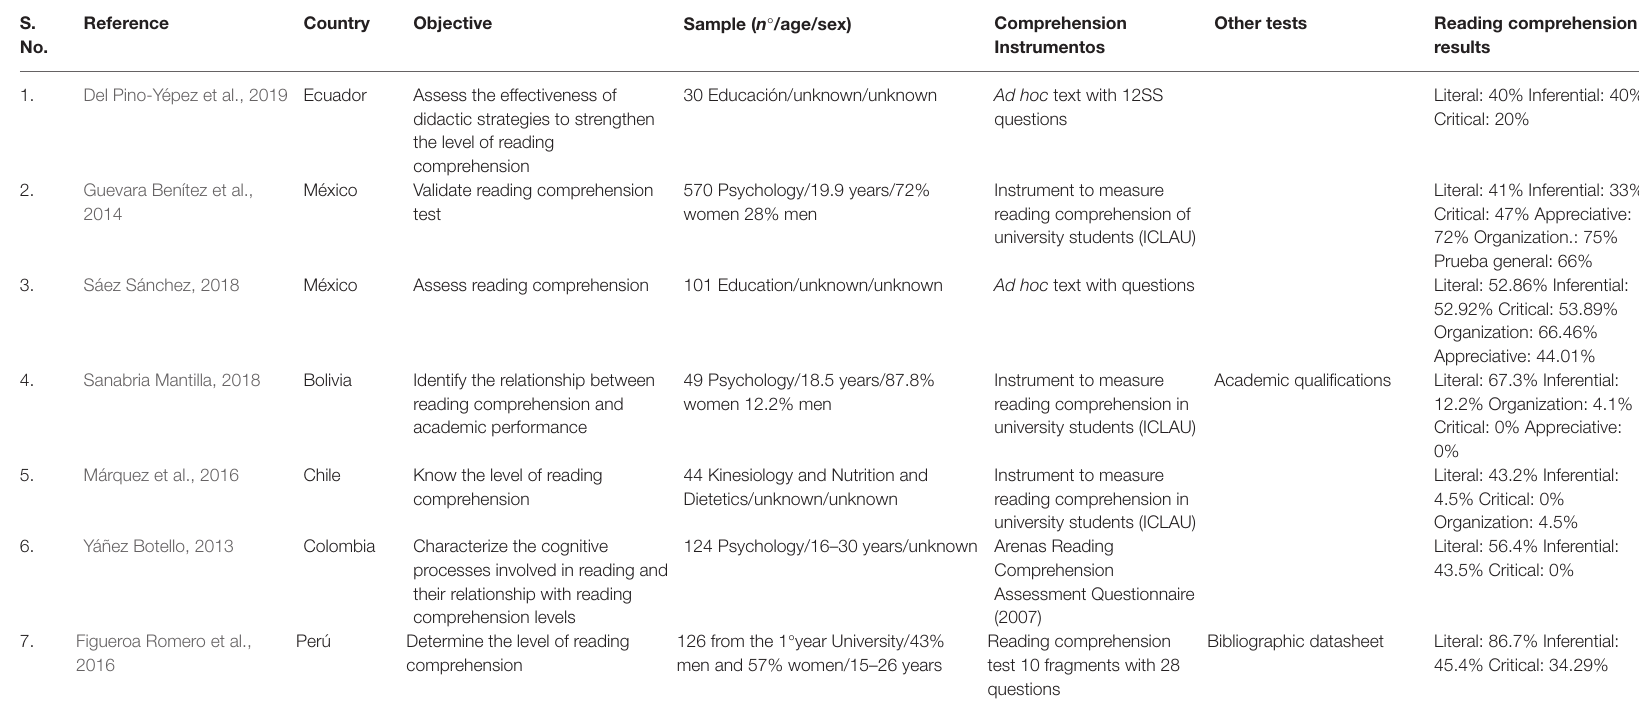
TABLE 1 | Results of the empirical studies included in the meta-analysis. S.